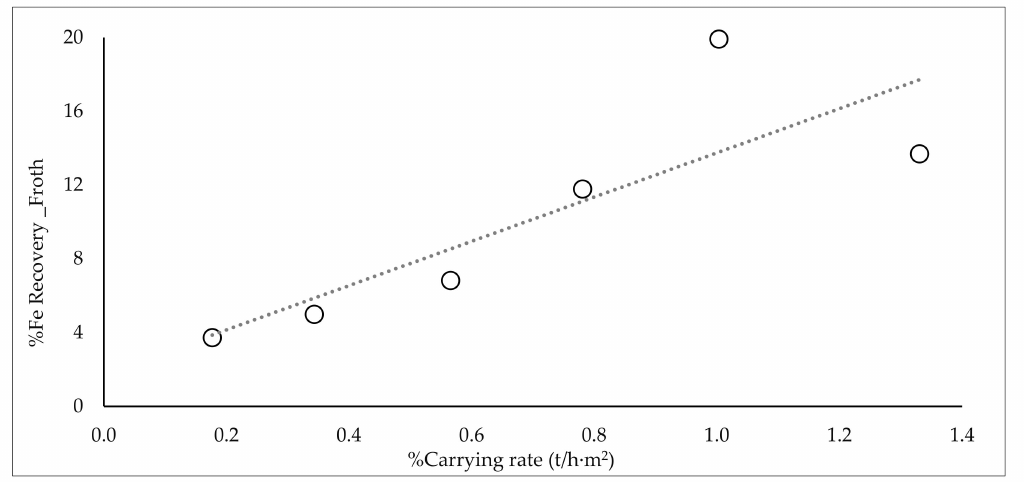
Figure 22. Trend between the carrying rate and Fe recovery to froth concerning the pilot test results.